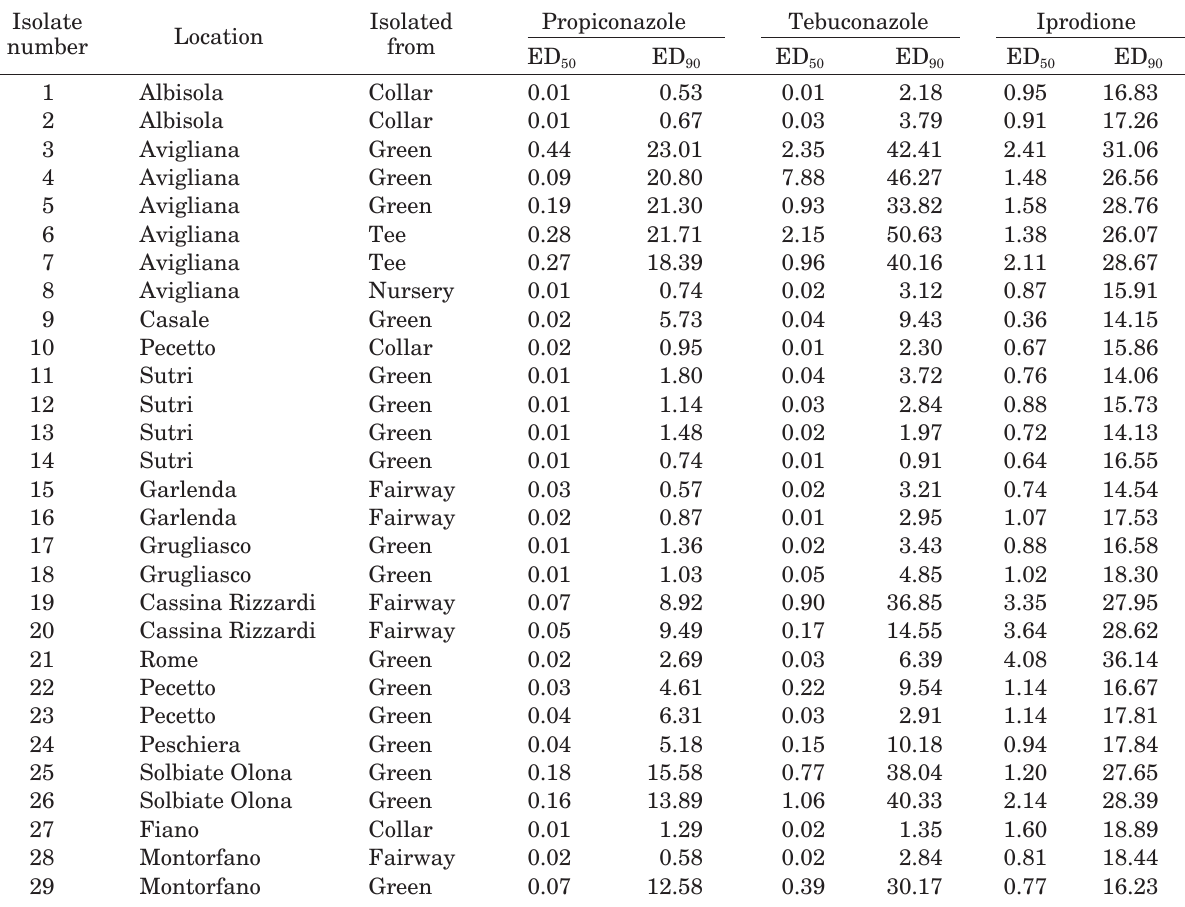
Table 3. Estimated ED and ED , values, expressed as µg mL -1 , to propiconazole, tebuconazole and iprodione, for 29 50 90 isolates of Sclerotinia homoeocarpa isolated from 13 Italian golf